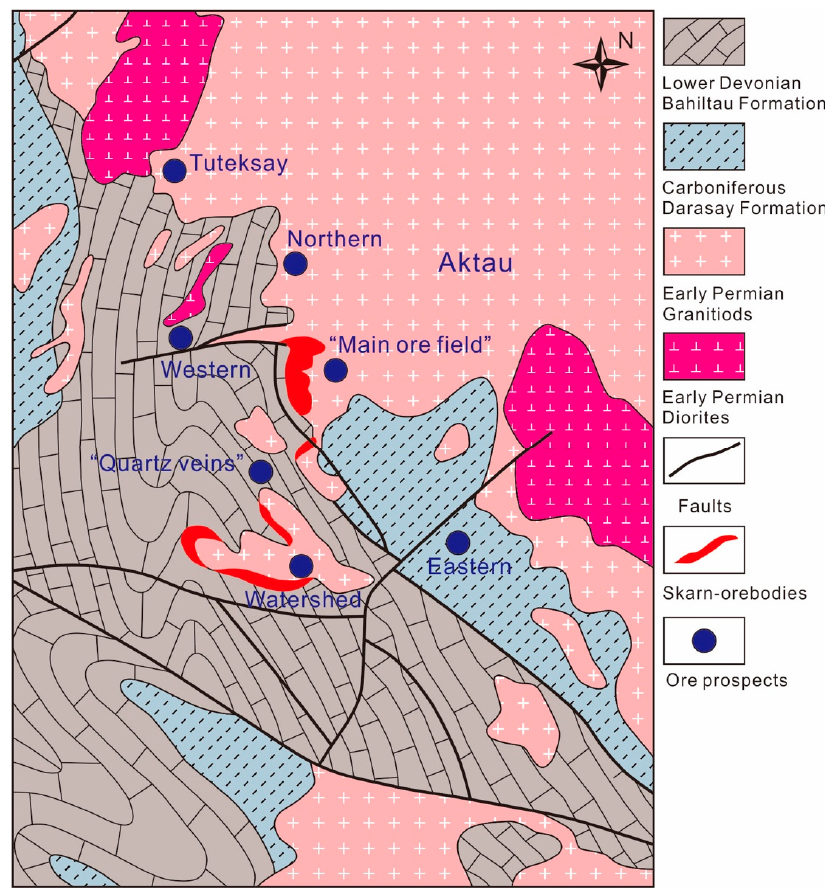
Figure 2. Simplified geologic map of the Lyangar W-Mo deposit (modified after [24]).